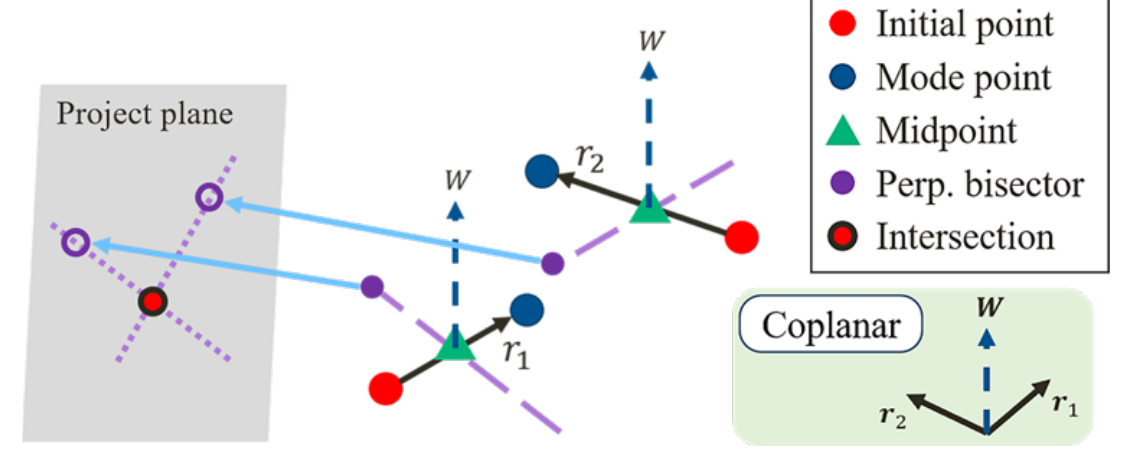
Machines 2022 , 10 , x FOR PEER REVIEW Figure 7. Project the perpendicular bisectors to the normal plane. Figure 7. Project the perpendicular bisectors to the normal plane.